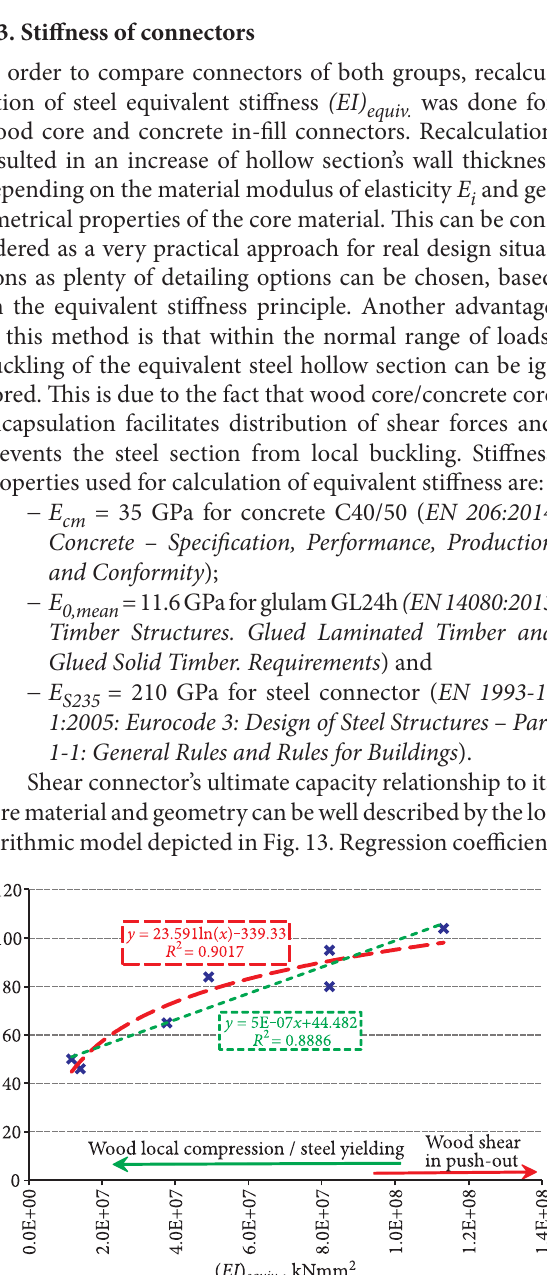
Fig. 13. Stiffness plot versus ultimate capacity of the shear connectors tested